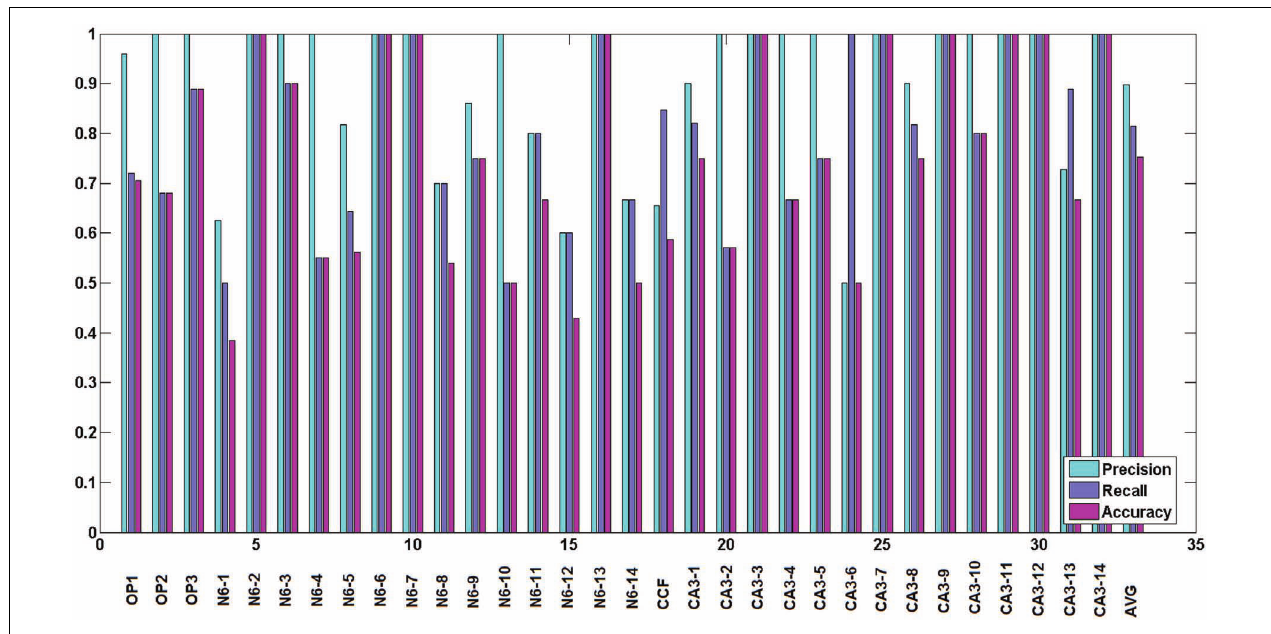
interneuron. The results for reconstructed topology are averaged over the topologies obtained with noise levels: 0, 0.01, 0.03, 0.05, 0.07, 0.09, 0.1, and 0.15. Last two bars show average similarity